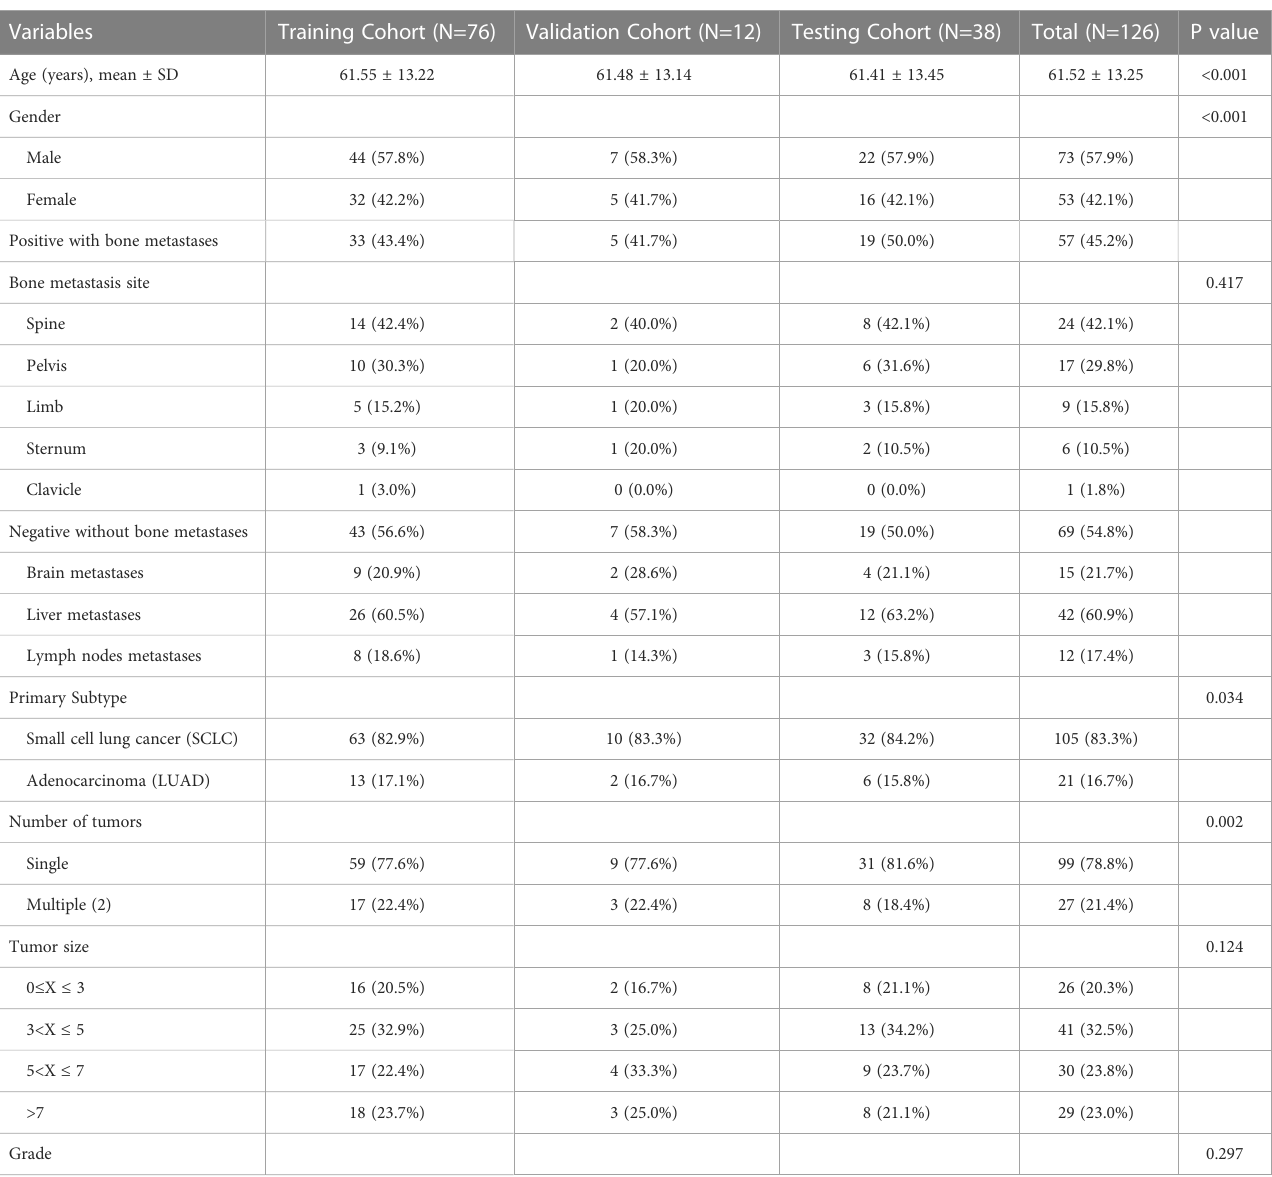
TABLE 1 Characteristics of patients in the three